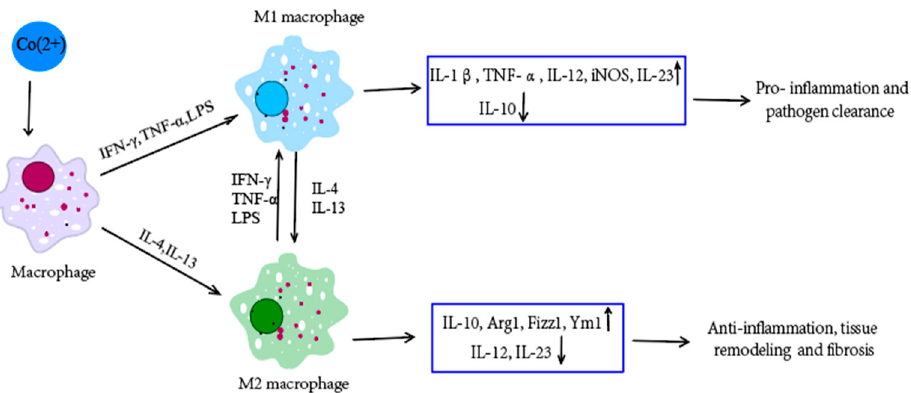
Figure 2. Co(2+) can induce inflammatory responses in macrophages [53]. Different environmental factors can induce the differentiation of macrophages into different subsets: M1 and M2 macrophages, which have different phenotypes, secrete different cytokines, and have different biological activities. M1 macrophages cells are activated by the classical way (activators include IFN- γ , TNF- α and LPS, etc.), which mainly play a role in killing microorganisms and promoting inflammation. M2 macrophage cells are activated by alternative ways (activators include IL-4 and IL-13), which are mainly involved in immune regulation, inhibition of inflammation, and tissue repair, and are related to the chronic progression of infectious diseases. M1 and M2 macrophages can transform into each other in different pathological processes and microenvironments. ↑ means upregulate and ↓ means downregulate.